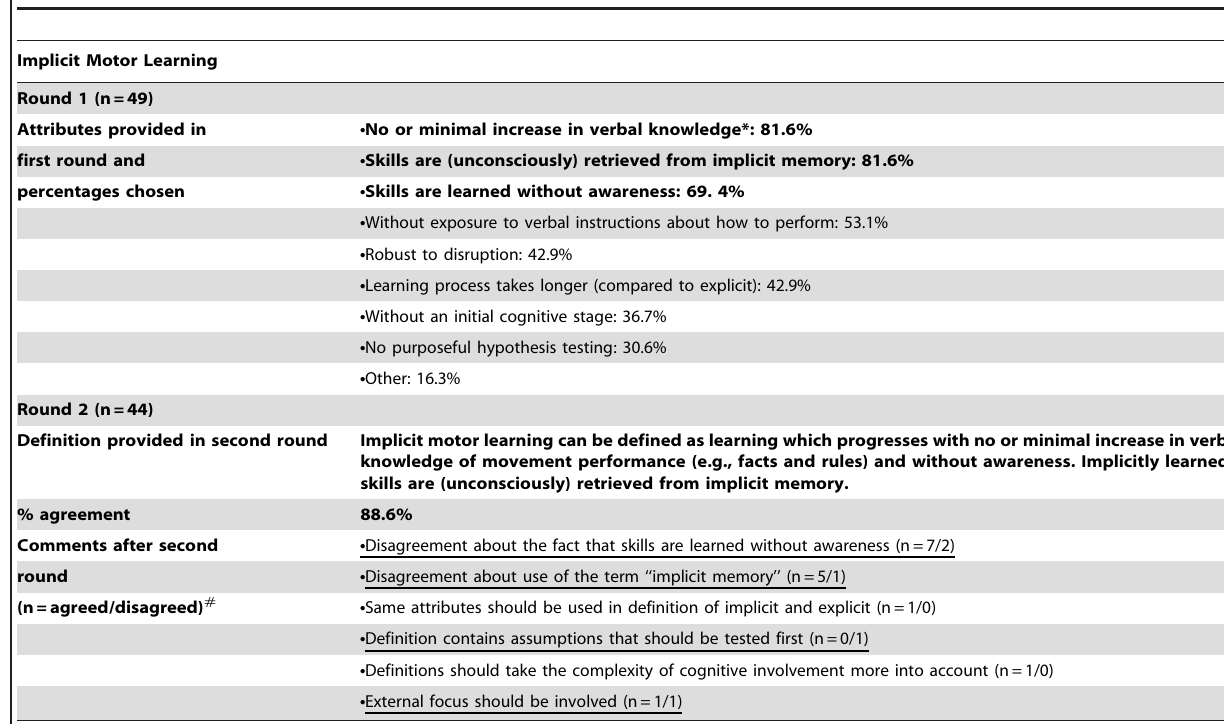
Table 4. Definition of implicit motor learning.